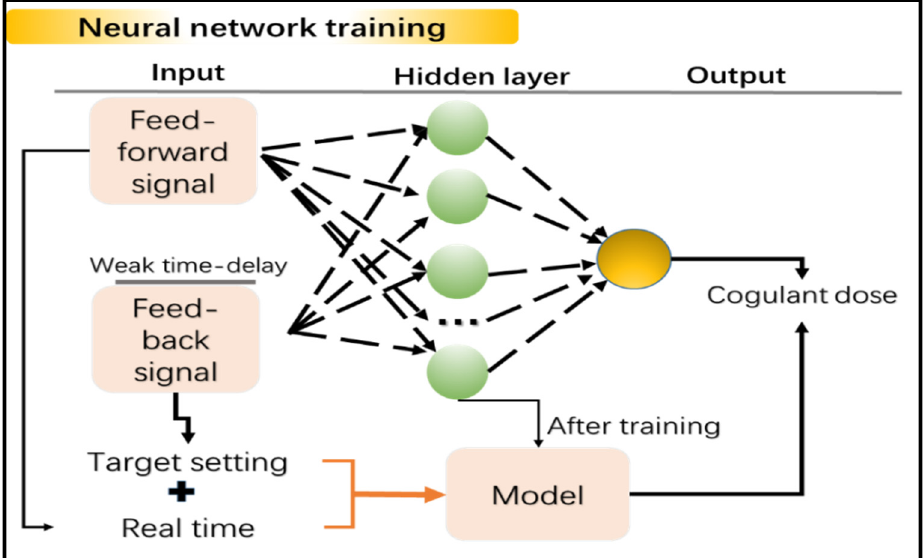
Figure 2. Proposed architecture of neural network model for flocculant dosing.